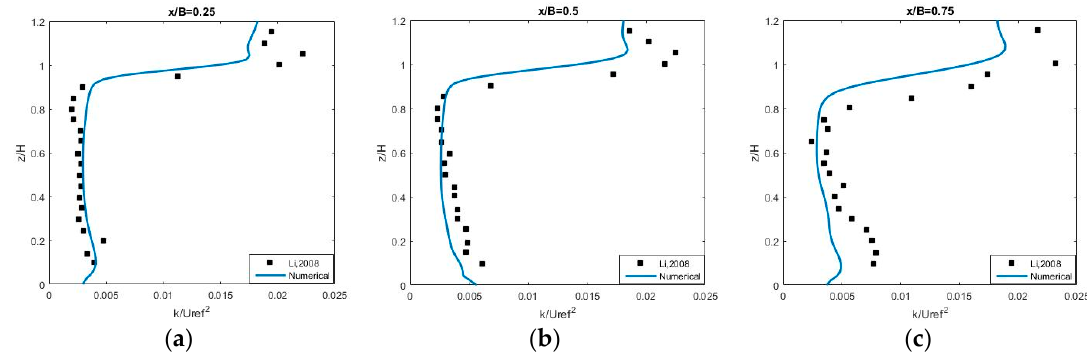
Figure 10. The vertical profile of stream-wise velocity ( a , c ) at center height (z/H = 0.5), and vertical velocity ( b , d ) roof height (z/H = 1) with AR = 1.